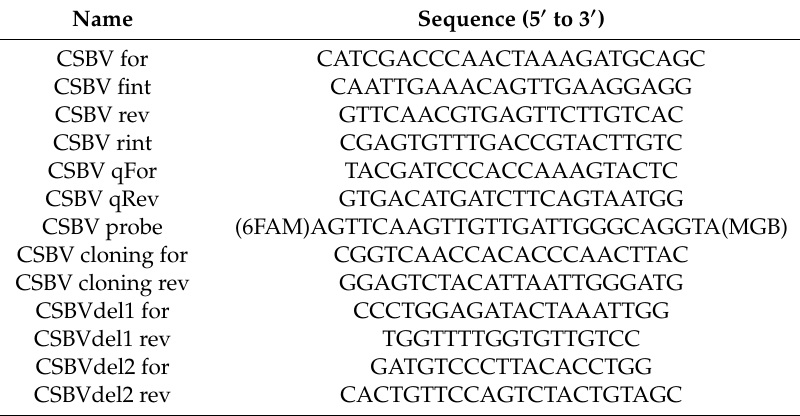
Table 1. Primer sequences designed to detect and identify Chinook salmon bafinivirus (CSBV). Primers used to clone the target sequence and the primers used to check the two large deletions in the polyprotein Iab gene are also